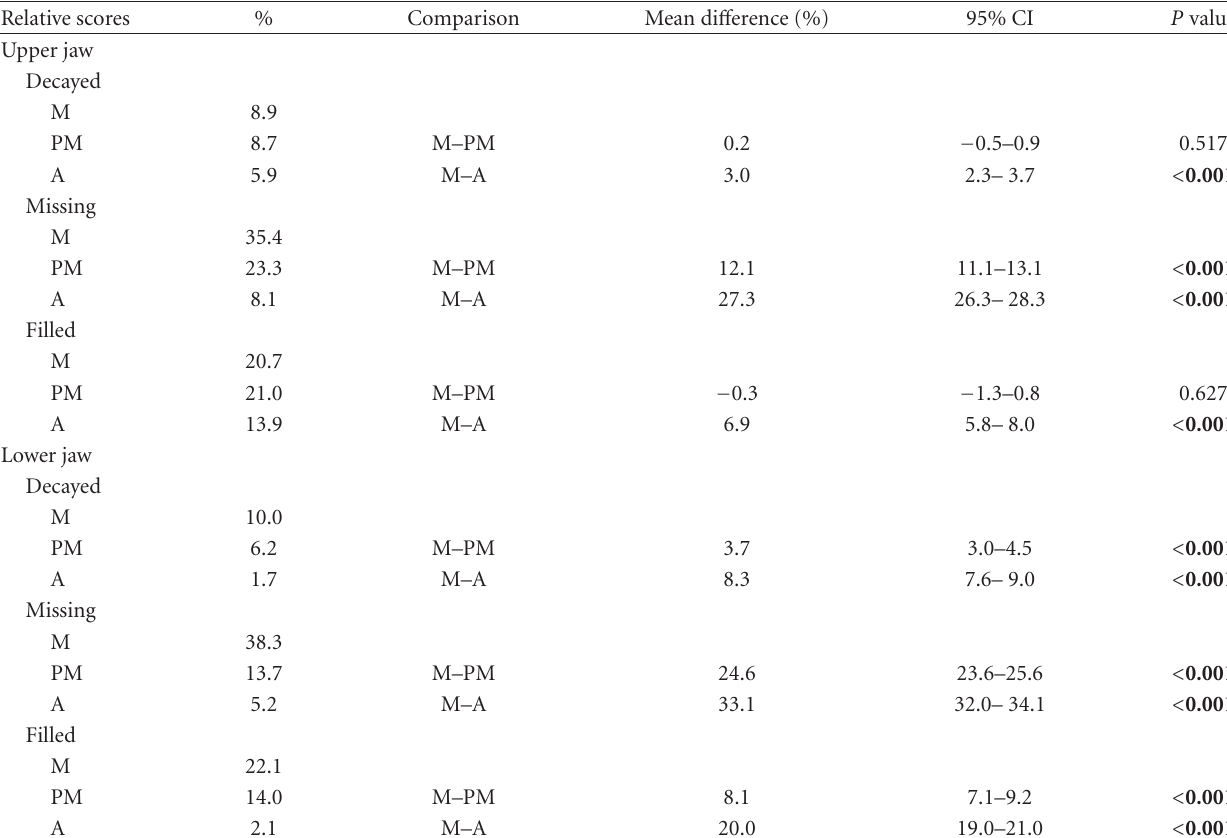
Table 4: Relative scores (%) for “decayed,” “missing,” and “filled” teeth in molar (M), premolar (PM), and anterior (A) dental region and mean di ff erence (%) of relative scores between the dental